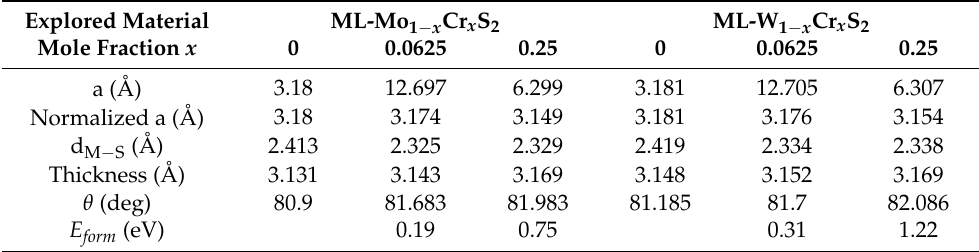
Table 1. List of the final optimized lattice parameters and the formation energy for ML-Mo 1 − x Cr x S 2 and ML-W 1 − x Cr x S 2 with respect to different mole fractions. For notations in the first column, the subscript M is Mo, W, and Cr atoms of ML-MoS 2 , ML-WS 2 , and their composites, including the Cr material, respectively. The normalized a is the a divided into the number of MoS 2 /WS 2 along the